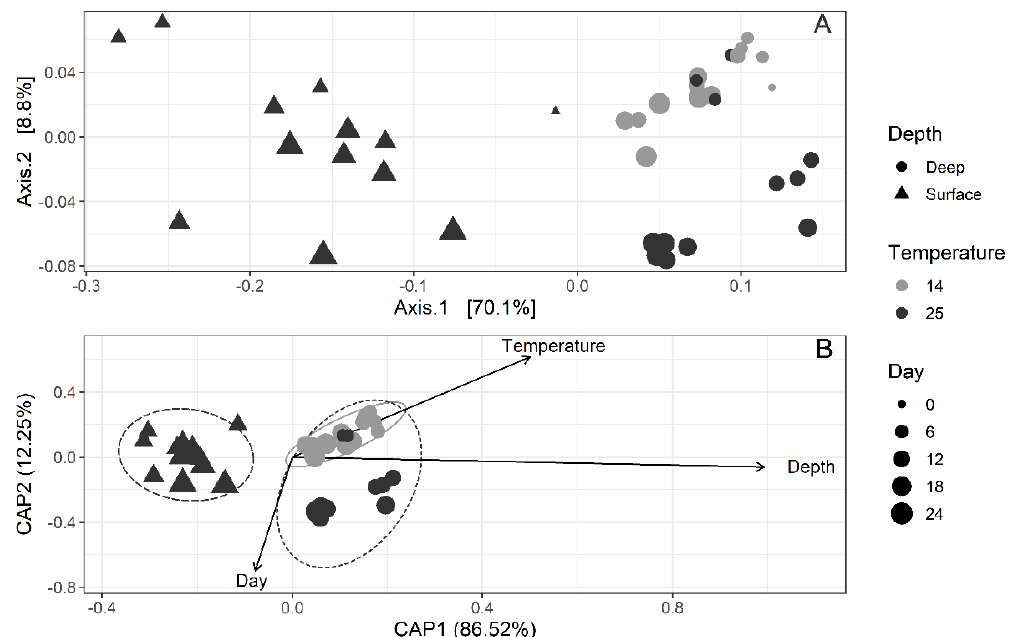
Figure 4. ( A ) Principal coordinate analysis (PCoA) of the weighted UniFrac distances. ( B ) Distance-based redundancy analysis (dbRDA) of the weighted UniFrac distances quantifying the impacts of depth, temperature and time on microbial community composition. Cumulative sum scaling (CSS) normalization was applied to the data prior to ordination analysis to account for differences in library size.